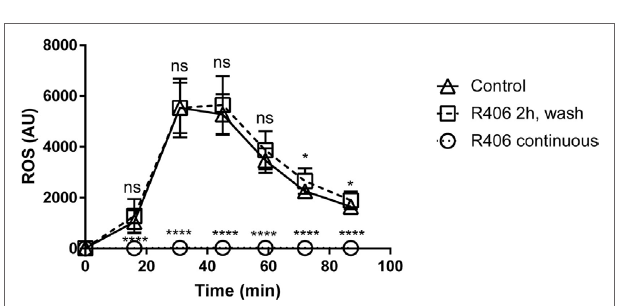
FigUre 5 | R406-induced spleen tyrosine kinase inhibition does not affect macrophage phagocytosis of C. glabrata . (a) Gating scheme for calculated percentage of macrophages that have phagocytosed CFSE-labeled C. glabrata by flow cytometry. (B) Percent phagocytosis of C. glabrata by macrophages over time incubated with control, R406, or cytochalasin D by flow cytometry. ** p ≤ 0.01, **** p < 0.0001. Data represent three independent